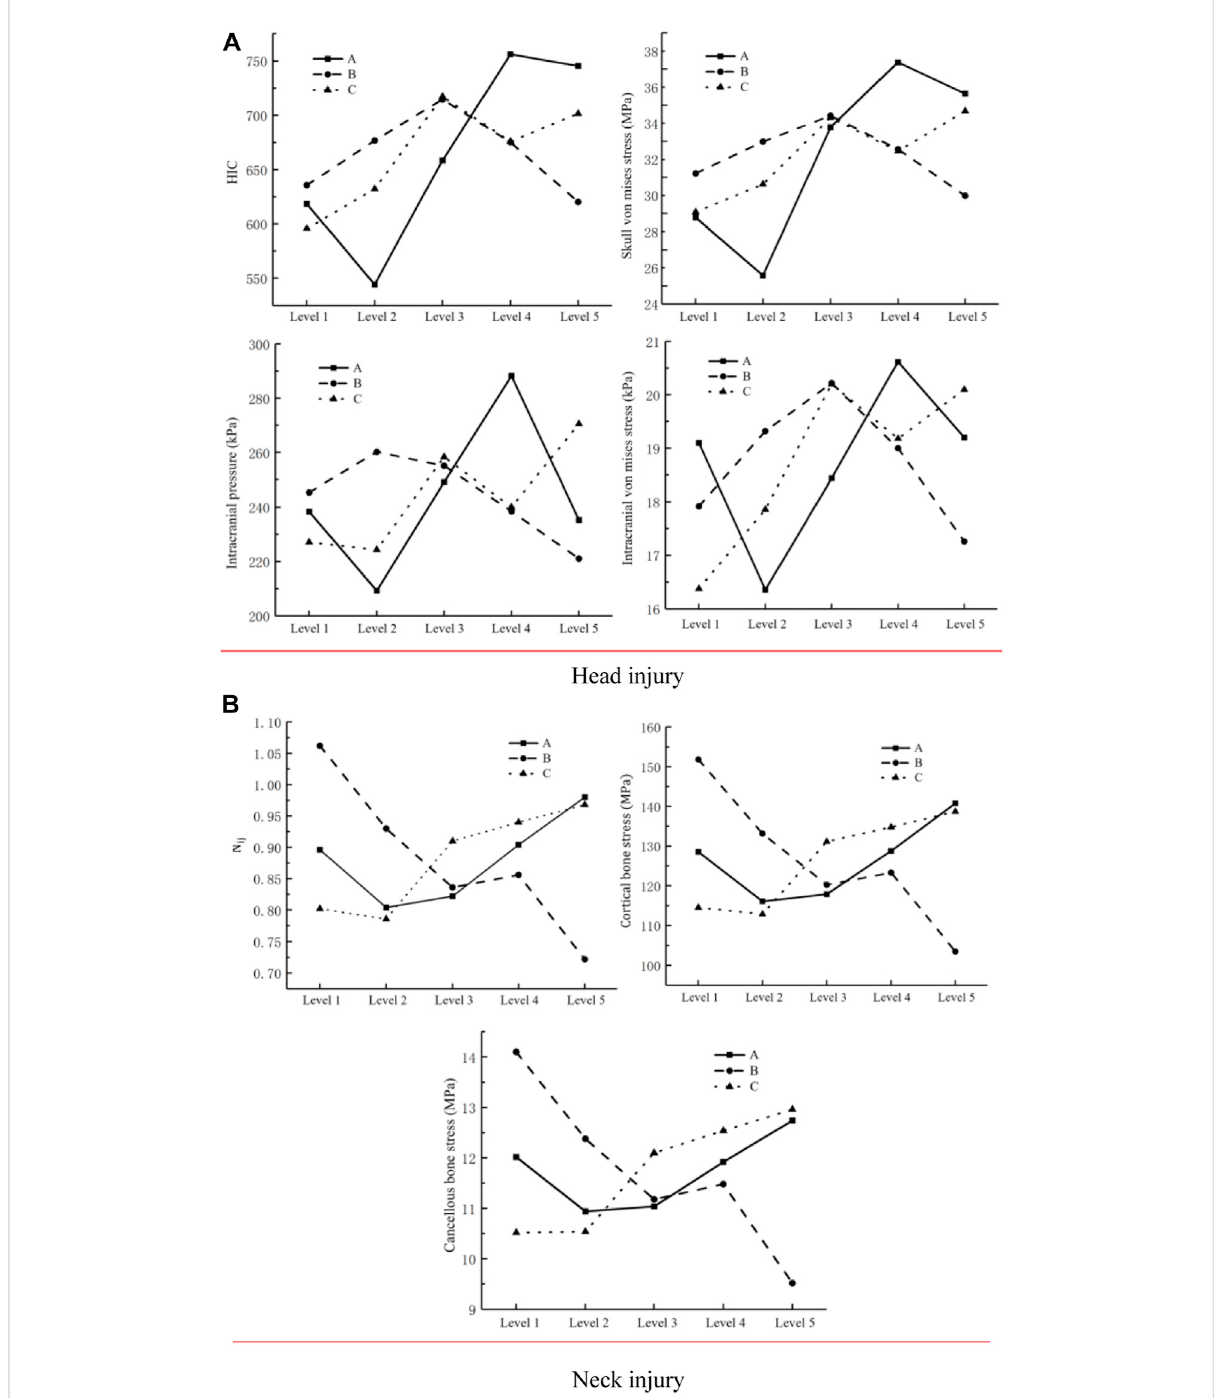
FIGURE 6 Pre-tensioned force-limiting seat belt variables ’ effect laws on head, neck, thorax, and leg injuries. (A) Head injury. (B) Neck injury. (C) Chest injury. (D) Leg injury.